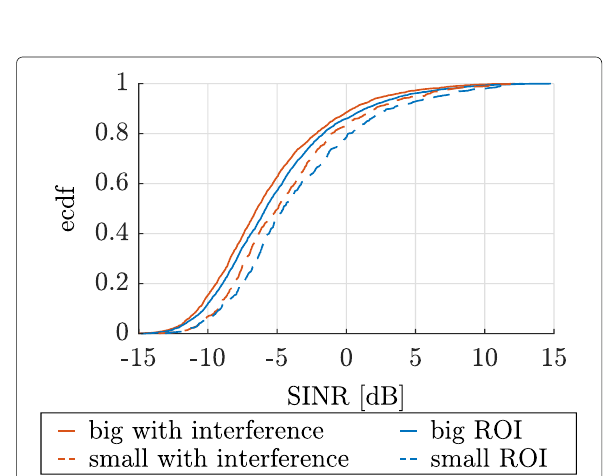
Fig. 13 SINR distribution with and without additional interference region. The SINR is overestimated in the scenarios without an additional interference